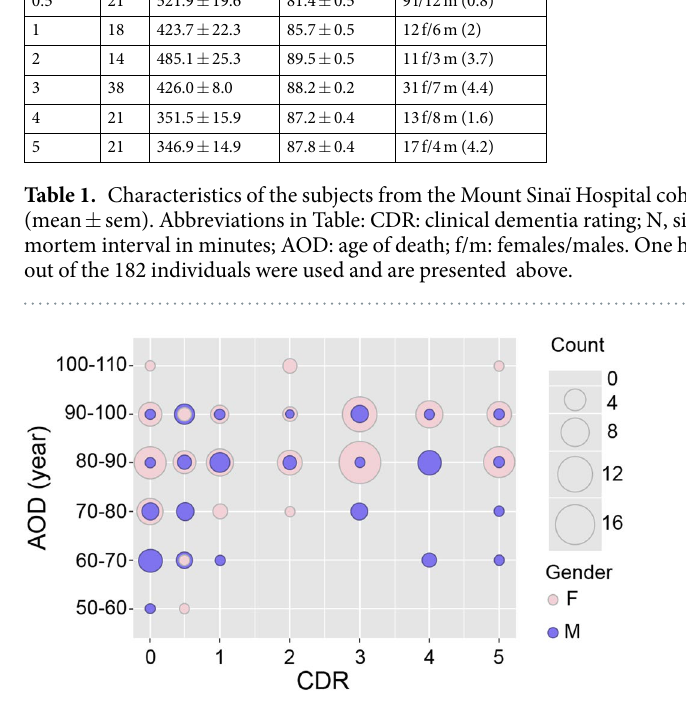
Figure 2. Gender distribution according to the CDR groups (x-axis) and age groups (y-axis). The balloon plots are proportional to the number of individuals in each CDR/age group. Men are shown in semi-transparent violet and women in pink. The number of individuals in each group is proportional to the size of the